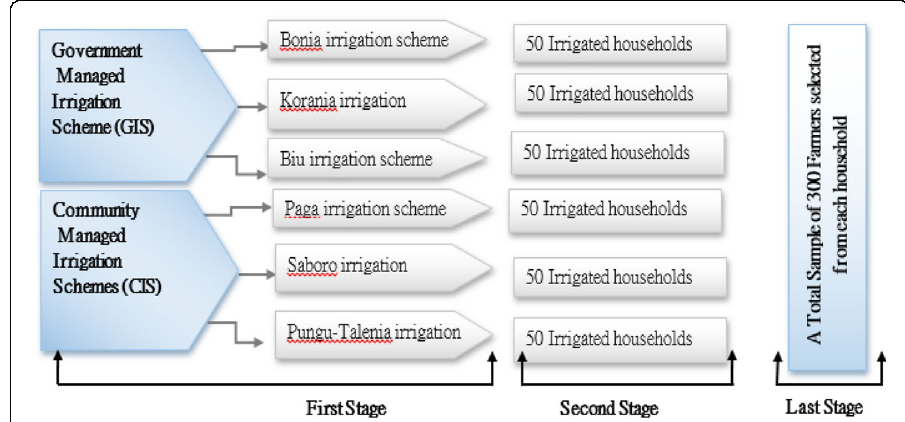
Fig. 2 Diagram showing the sampling procedure and sample size. Source: Agula et al.